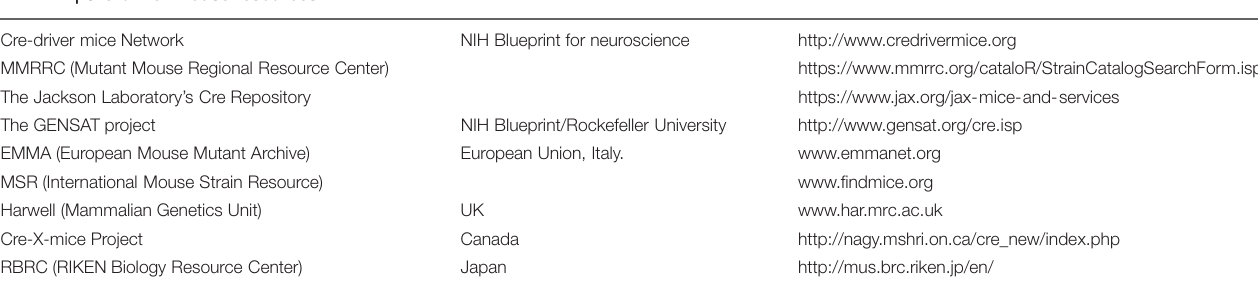
TABLE 1 | Cre-driver mouse